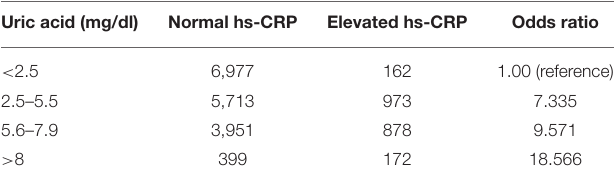
TABLE 1 | Odds ratio test for trend, uric acid, and elevated hs-CRP. Uric acid (mg/dl) Normal hs-CRP Elevated hs-CRP Odds